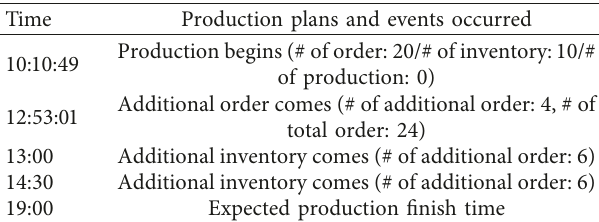
Figure 8: Bird-eye view of the DigTwinOps-based CPPS. Table 1: Initial production plan and daily events. Table 2: Possible control